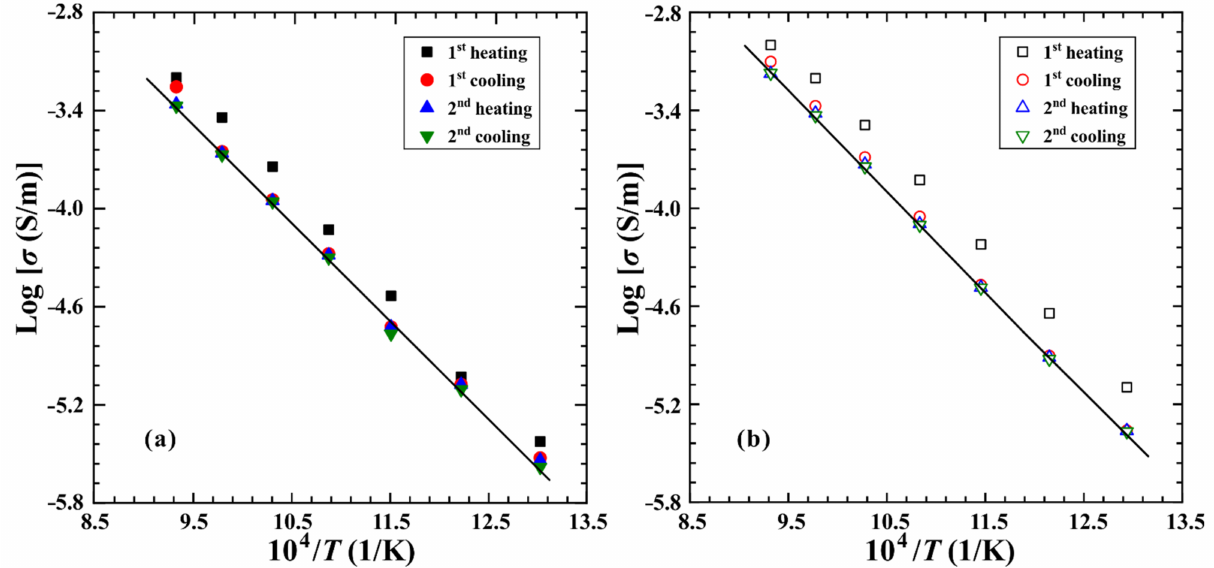
Figure 5. The electrical conductivities of the hot-pressed sintering gabbro among two heating–cooling cycles at a pressure of 1.0 GPa. Here, ( a , b ) represent the samples of Cp x 30 P l 70 and Cpx 70 Pl 30 ,